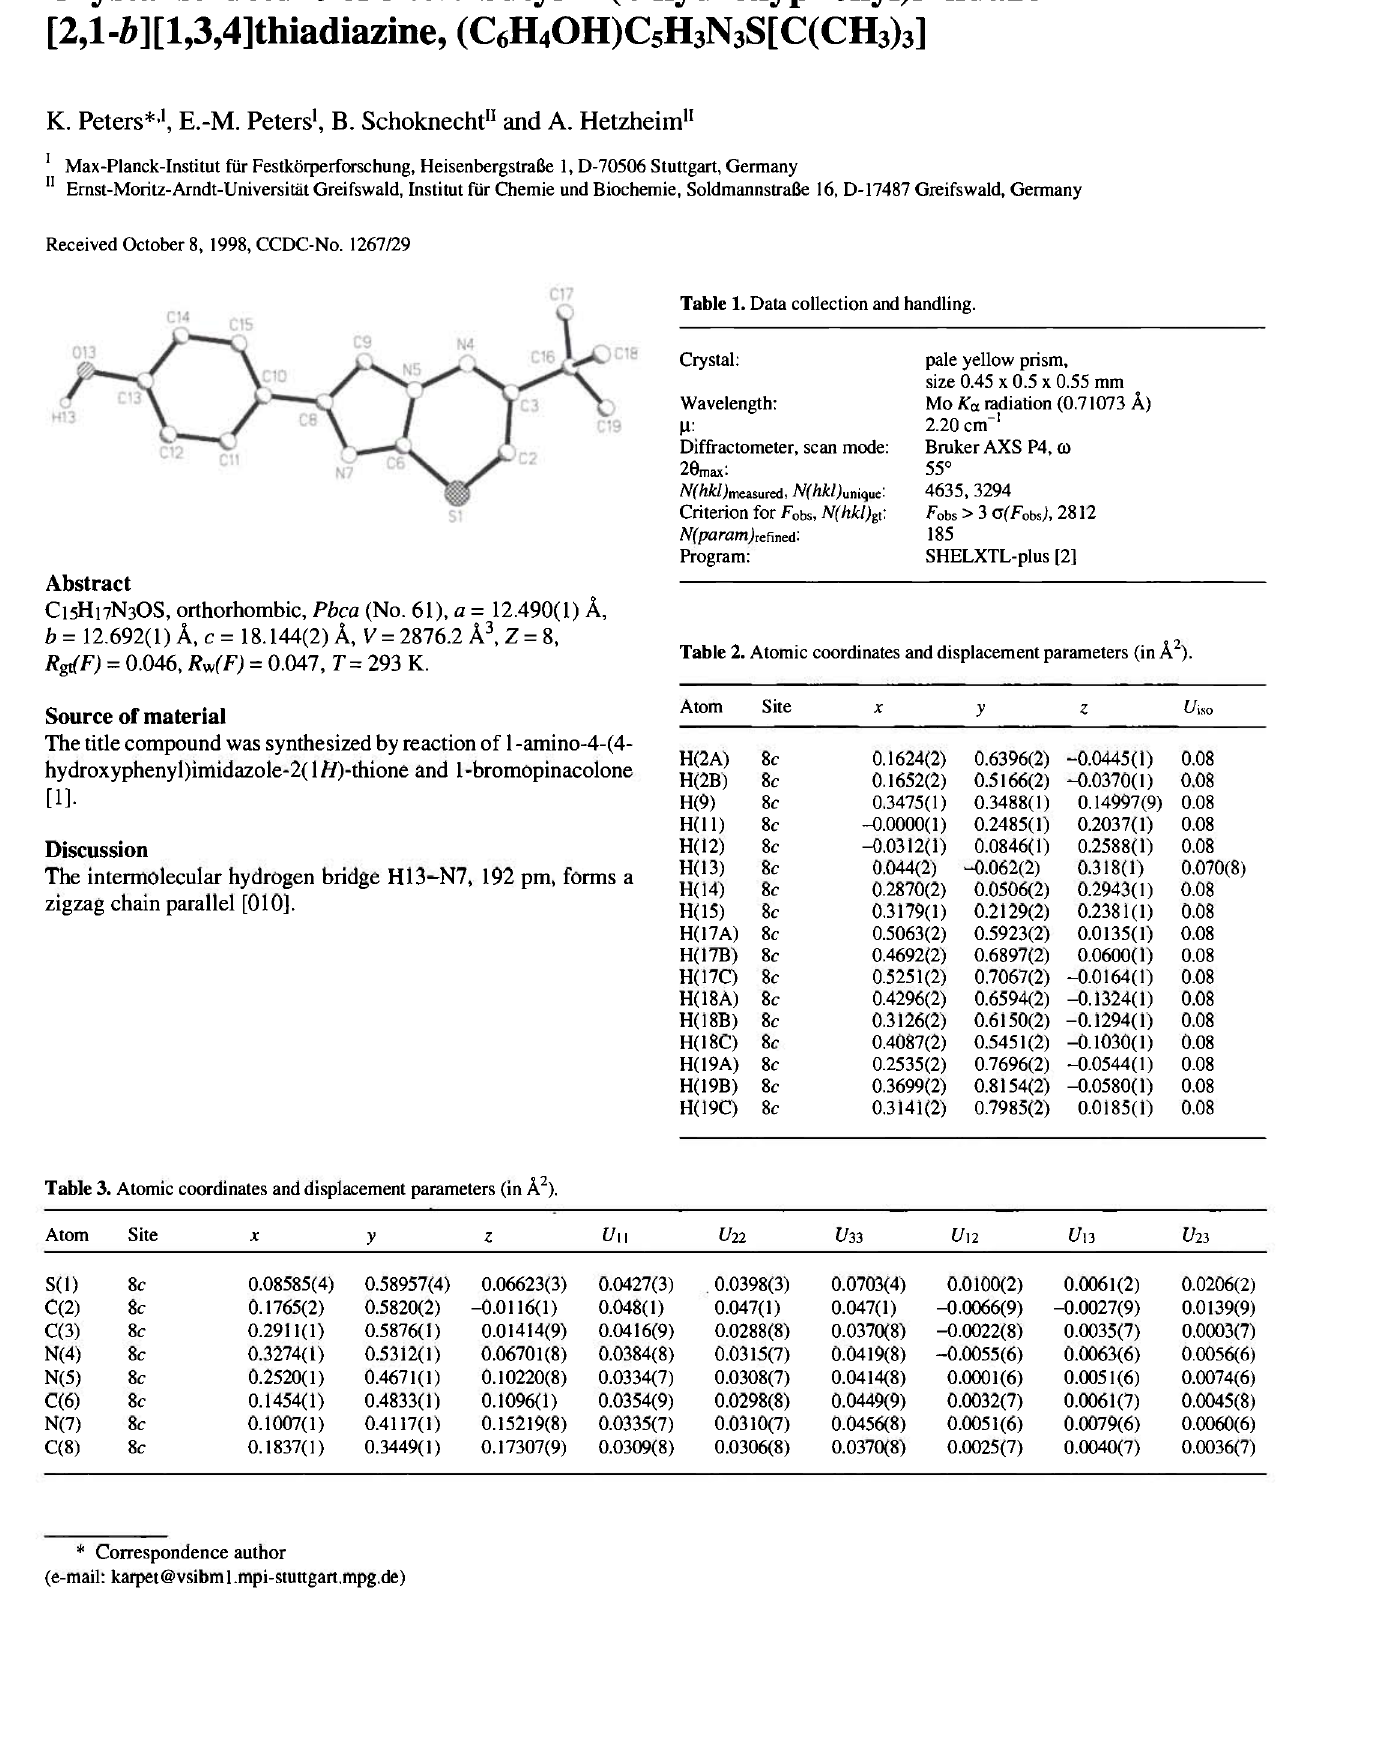
Table 1. Data collection and handling.